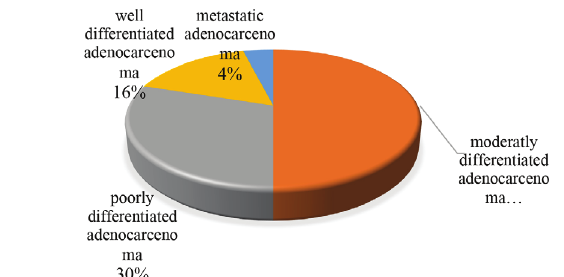
Figure 4. Presence of tumor based on the different location in the colon and rectum part of large